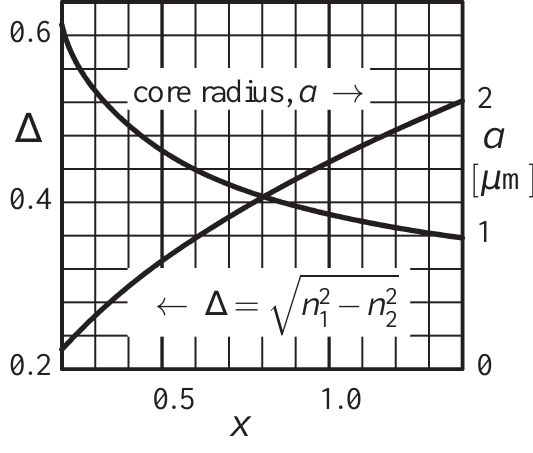
n 2 n 2 , in a monomode dielectric cylindrical 2 1 − (cid:113) x Ga x O 12 , in the cladding. −